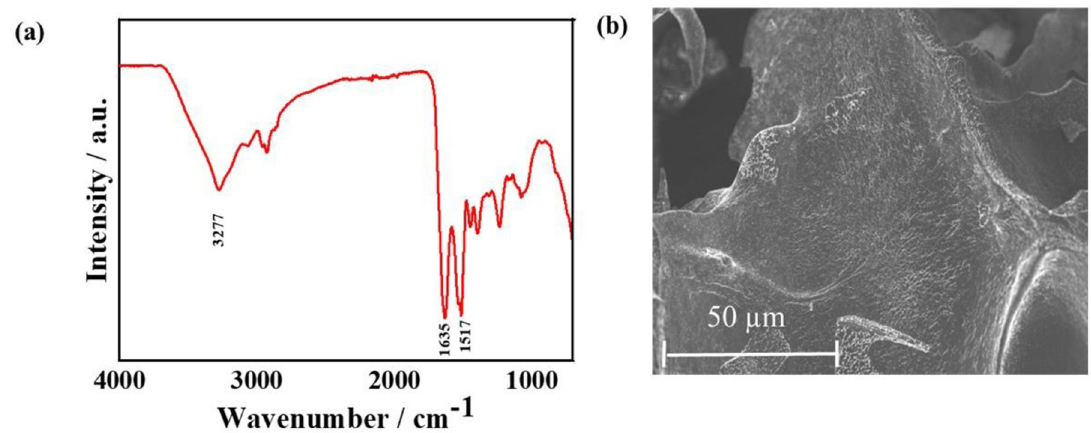
Fig 3. Chemical characterization of CPI. (a) The FTIR spectrum of the CPI extracted from insect, and (b) FE-SEM morphology of freeze-dried CPI.